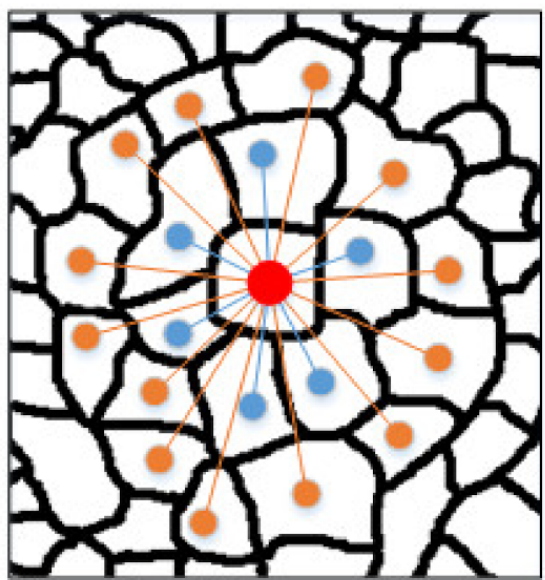
Figure 2. Schematic diagram of two-order neighborhood connection. The red node denotes the central node. The blue nodes denote the one-order neighbors of the central node. The orange nodes denote two-order neighbors of the central